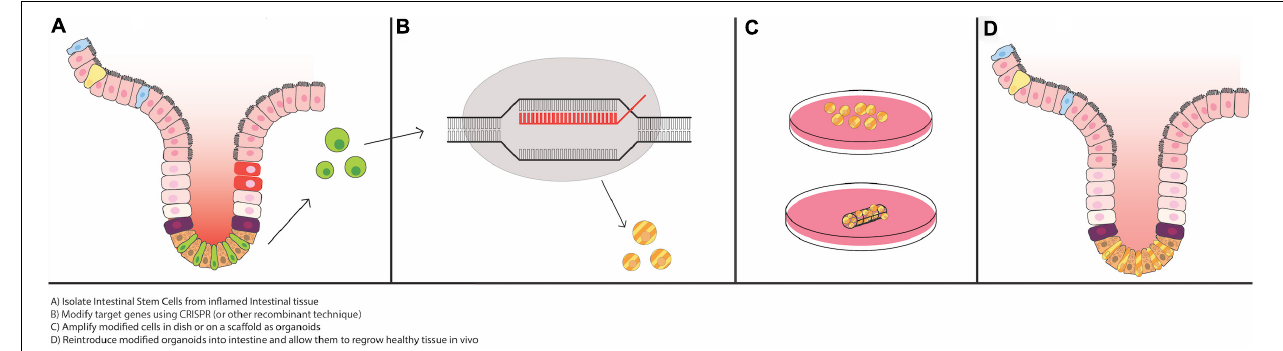
FIGURE 3 | Potential for use of intestinal organoids as “grafts” for the damaged epithelium. Recent advances in epithelial regeneration via organoid transplantation have shown that it could be possible to recover a damaged intestine or colon with autologous organoid transplantation. One approach to improve efficacy in engraftment and recovery post damage would be to isolate intestinal stem cells (ISCs) from the inflamed tissue, or if possible, non-inflamed adjacent tissue, modify target genes via CRISPR or equivalent recombinant techniques, expand the modified ISCs in vitro , and engraft back into the damaged area to recover the injured area. Tissue scaffolds, either synthetic or derived from human intestinal resections, could facilitate growth and proper cellular